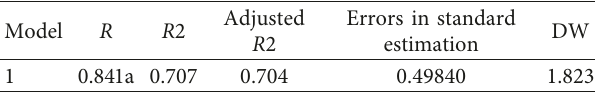
Table 4: Variable DW test